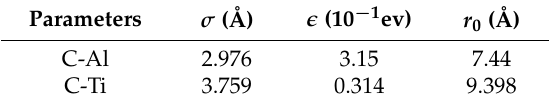
Figure 1. Nanoindentation model of γ -TiAl. Table 1. Mie 6–12 (Lennard–Jones) potential function parameters used in simulation.